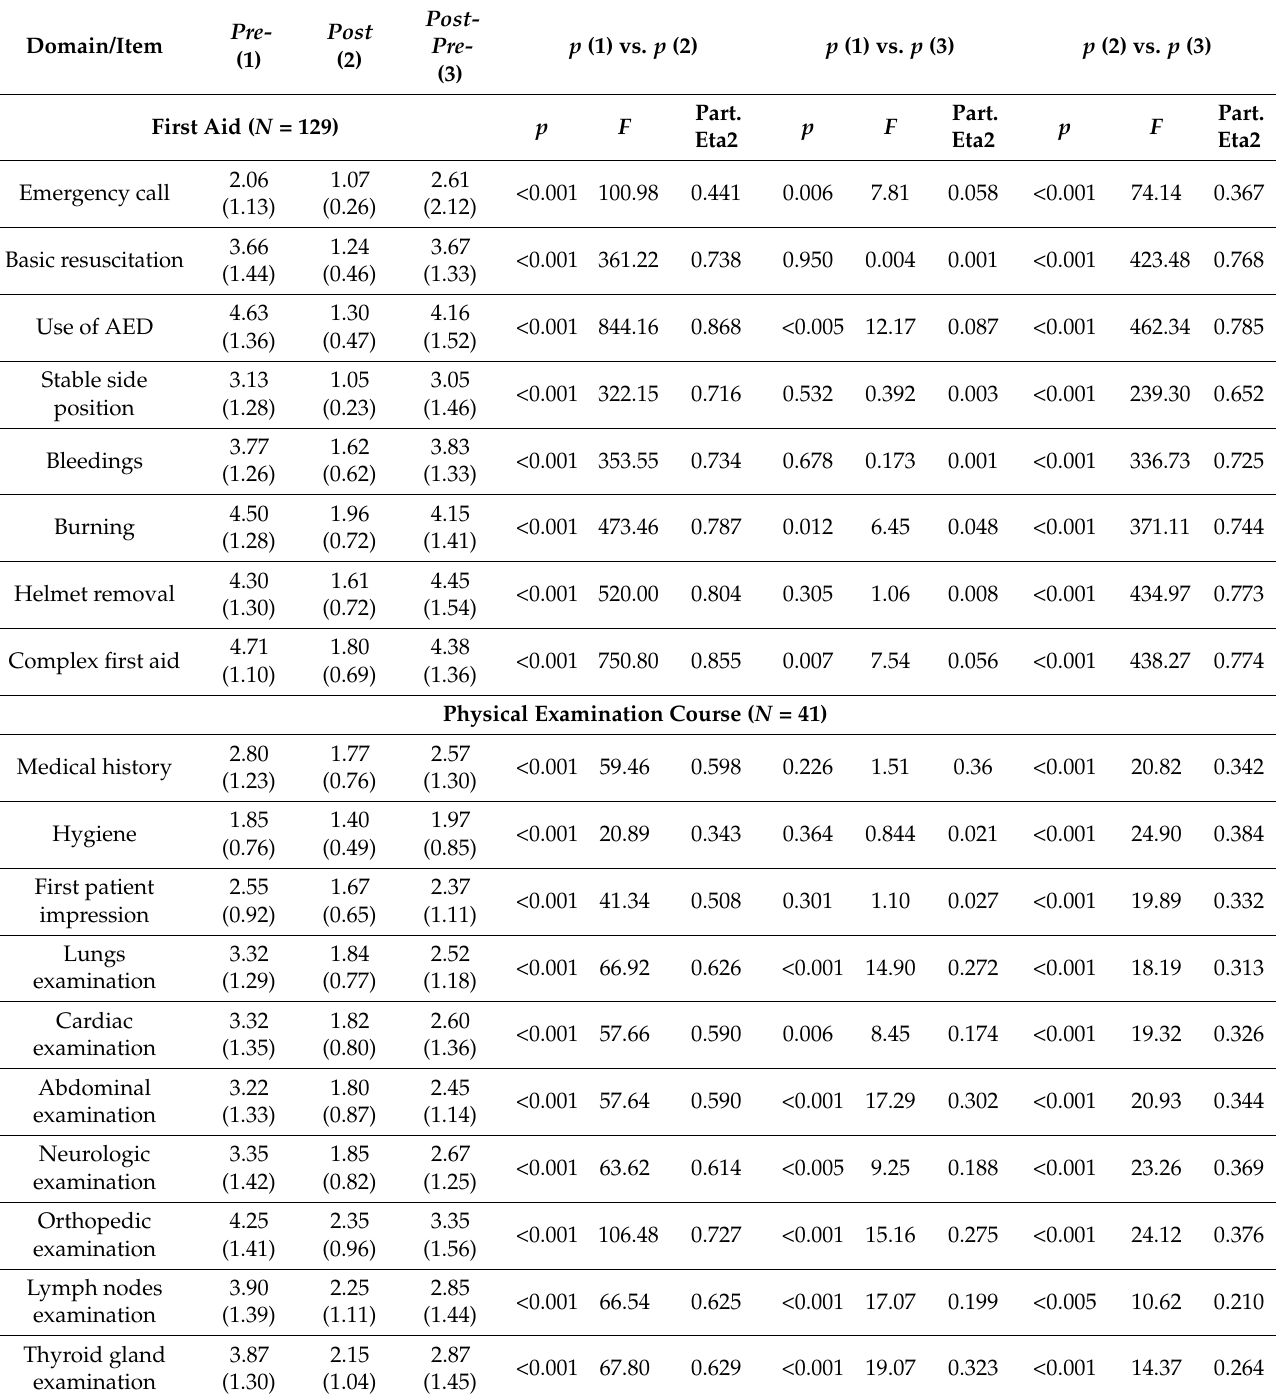
Table 2. Compared evaluation data of course attendees with regard to self-reflection of